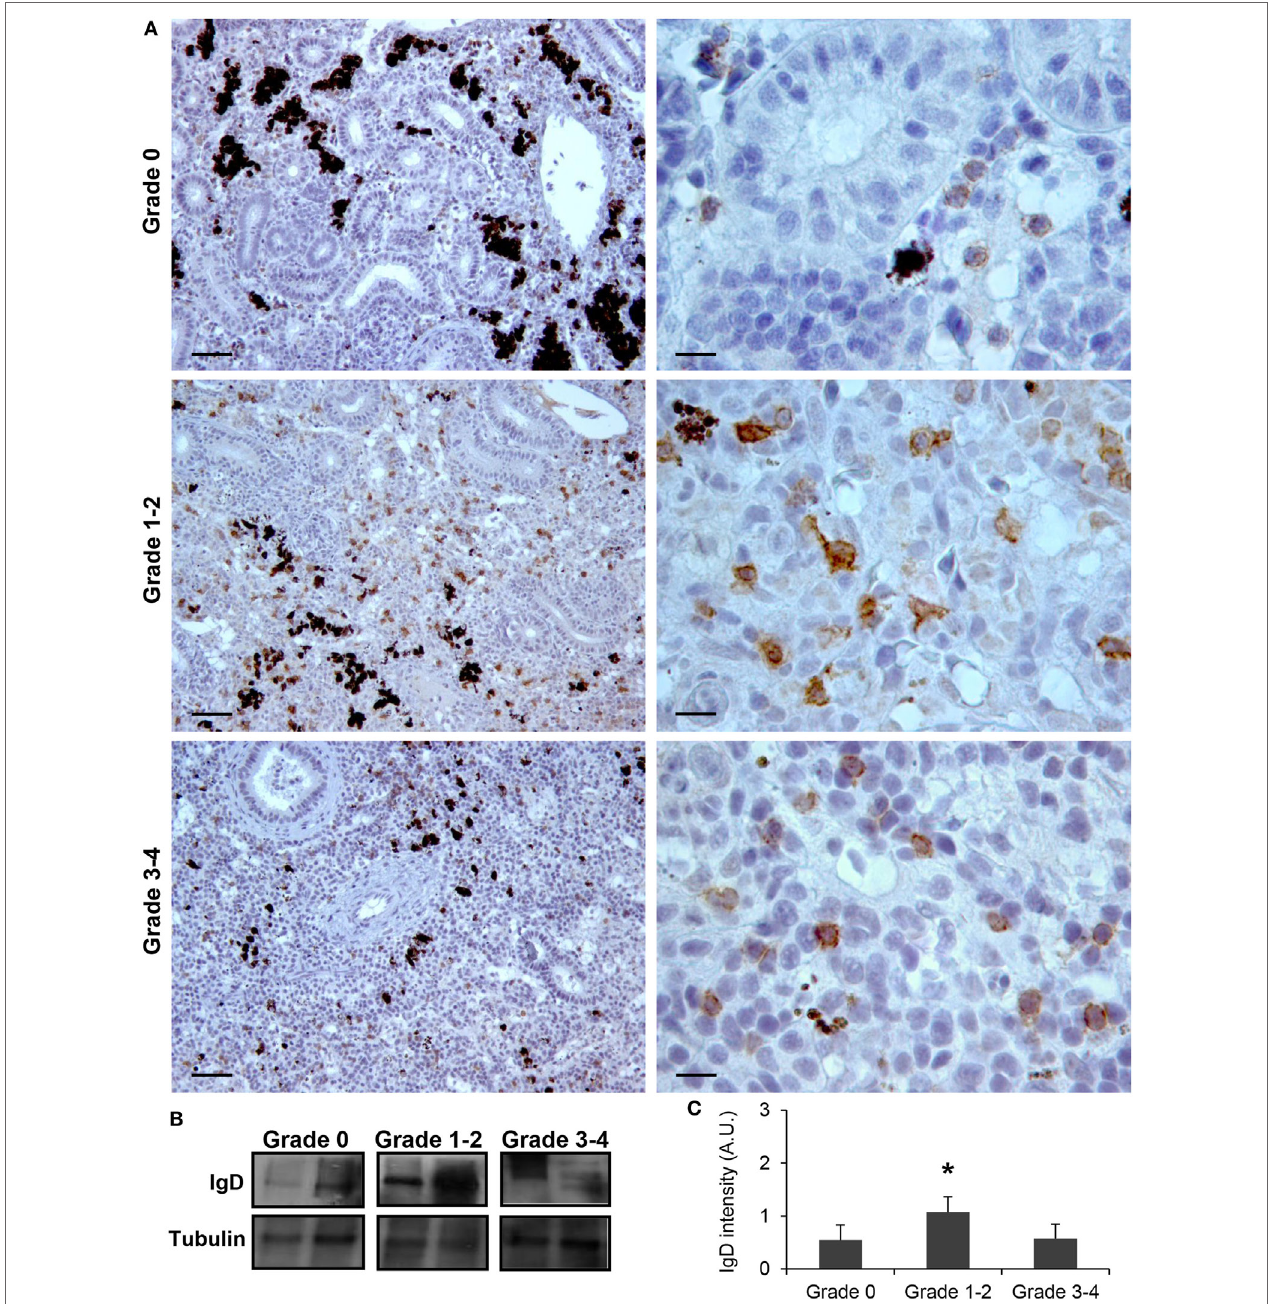
FigUre 2 | IgD production increases during proliferative kidney disease infection. (a) Immunohistochemical detection of IgD + cells in the kidney of parasite­infected (swelling grades 1–4) and parasite­naïve (swelling grade 0) fish. Representative images for fish with swelling grades 0, 1–2, and 3–4 are shown at 20 × magnification (left images, scale bars = 40 µm) and at 100 × magnification (right images, scale bars = 10 µm). IgD production in trunk kidney samples from each fish group was analyzed by Western blot. (B) Results from two representative individuals in each group are shown. (c) Abundance of IgD was quantified by optical densitometry and normalized against α ­tubulin. Mean values in arbitrary units (A.U.) + SEM are shown ( n = 4). Asterisks (*) denote significant differences ( P < 0.05) between values obtained in grade 1–2 or grade 3–4 and grade 0 kidneys (analyzed by a two­tailed Student’s t ­test).